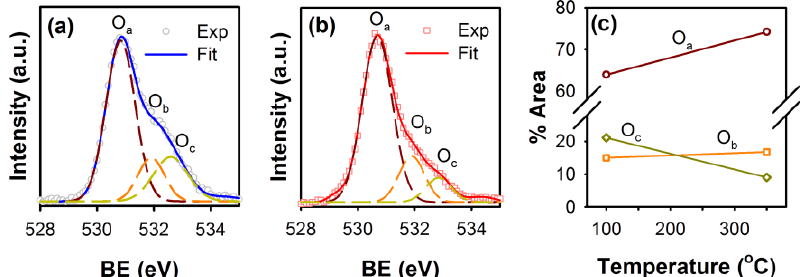
Figure 3. Oxygen 1s XPS spectra of ZnO nanorods annealed at ( a ) 100 °C and ( b ) 350 °C. The O1s spectra were coherently fitted with three Gaussian peaks (O a , O b and O c ); ( c ) Percentage variations in the area under O a , O b and O c representing the chemical states of oxygen at two different annealing temperatures of the ZnO nanorods.